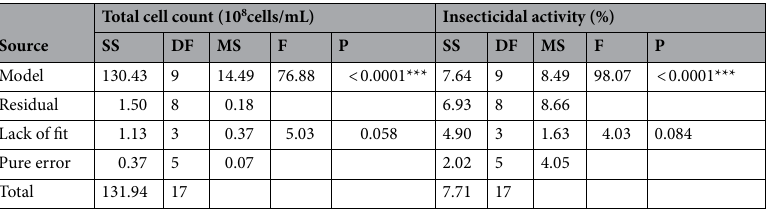
Table 4. ANOVA for the quadratic model. SS sum of squares, DF degree of freedom, MS mean square, F F-value, P P-value. ***Significant at the level 99.9%.